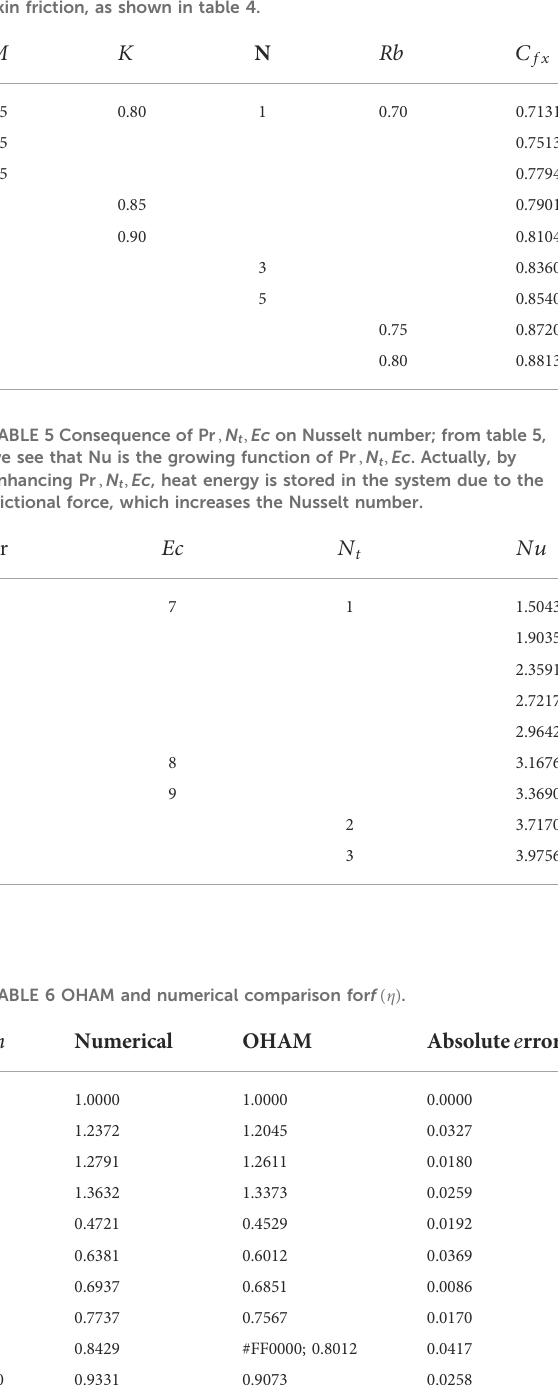
TABLE 4 Consequence of different parameters such as M , K , N , Nb on skin friction, from table 4, we see that skin friction is the decreasing function of M , K , N , Nb . Physically, by increasing these parameters the surface friction forces increase due to the increase in skin friction, as shown in table 4.